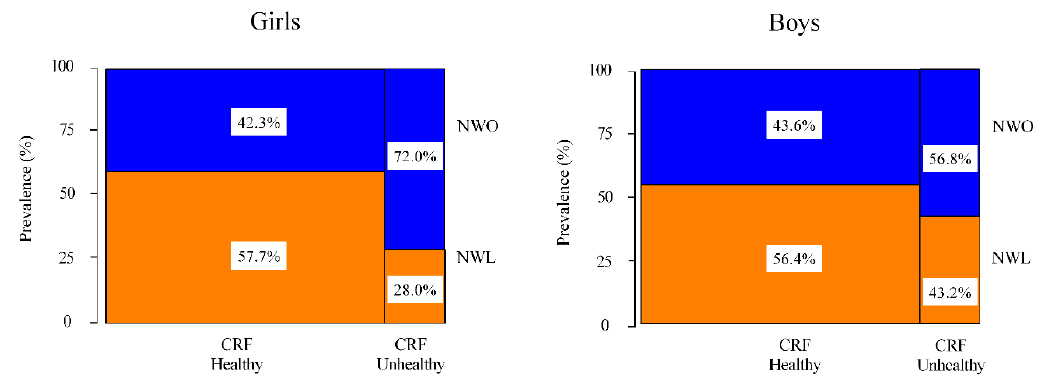
Figure 1. Mosaic plot depicting the frequency of participants (%) in each obesity group (normal-weight lean (NWL), normal-weight obesity (NWO)), cardiorespiratory fitness (CRF) categories (healthy, unhealthy) by sex. NWO was defined as a BMI < 25 kg / m 2 and a percentage of body fat over the sex-age-specific 90th percentile for Colombian children and adolescents (boys > 23.4%–28.3% and girls > 31.0%–34.1%) [12]. CRF were grouped into two groups (i.e., healthy and unhealthy) according to previously suggested cut-o ff points associated with high cardiovascular disease risk in Colombian children and adolescents [15]. These cut-o ff points were defined as < 47.9 mL · kg − 1 · min − 1 in boys and < 34.4 mL · kg − 1 · min − 1 in girls aged 9–12.9 years, and < 48.0 mL · kg − 1 · min − 1 in boys and < 33.8 mL · kg − 1 · min − 1 in girls aged 13–17.9 years, respectively.